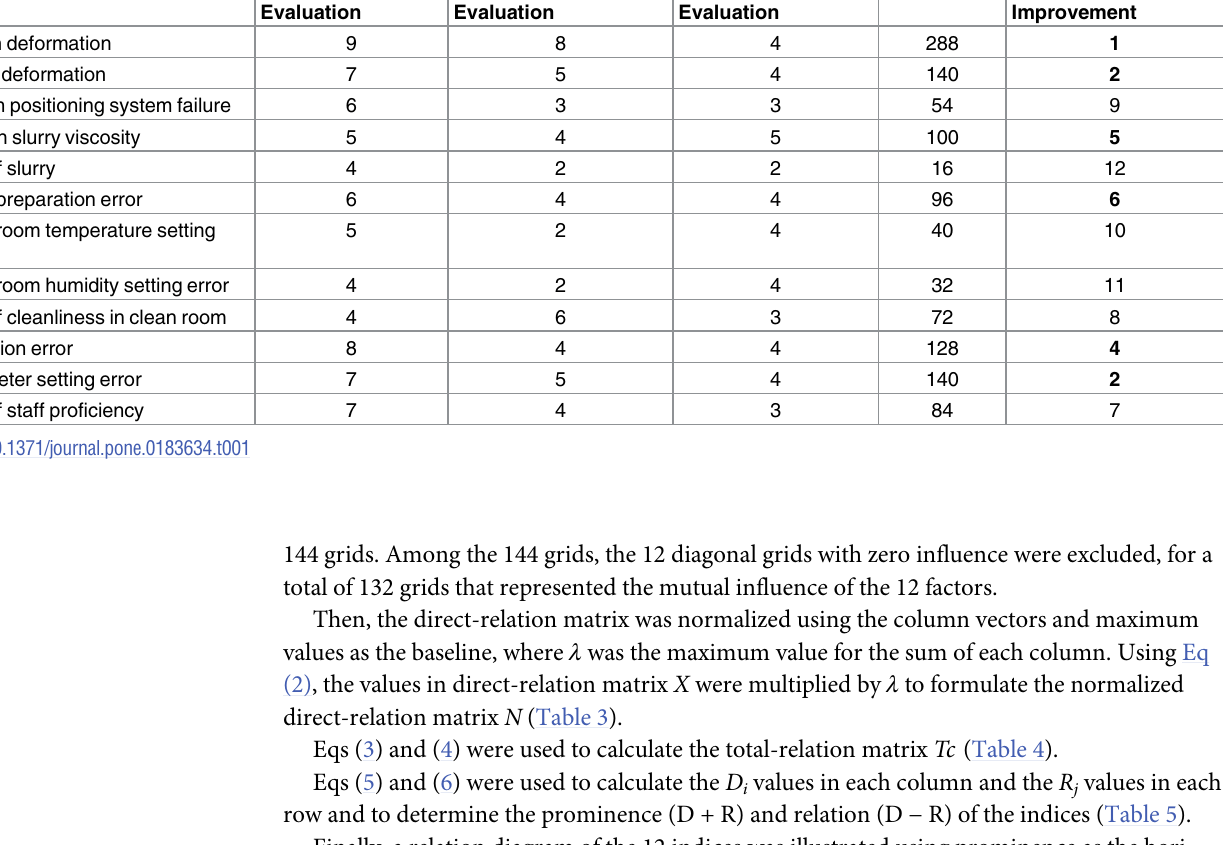
Table 1. FMEA analysis results.